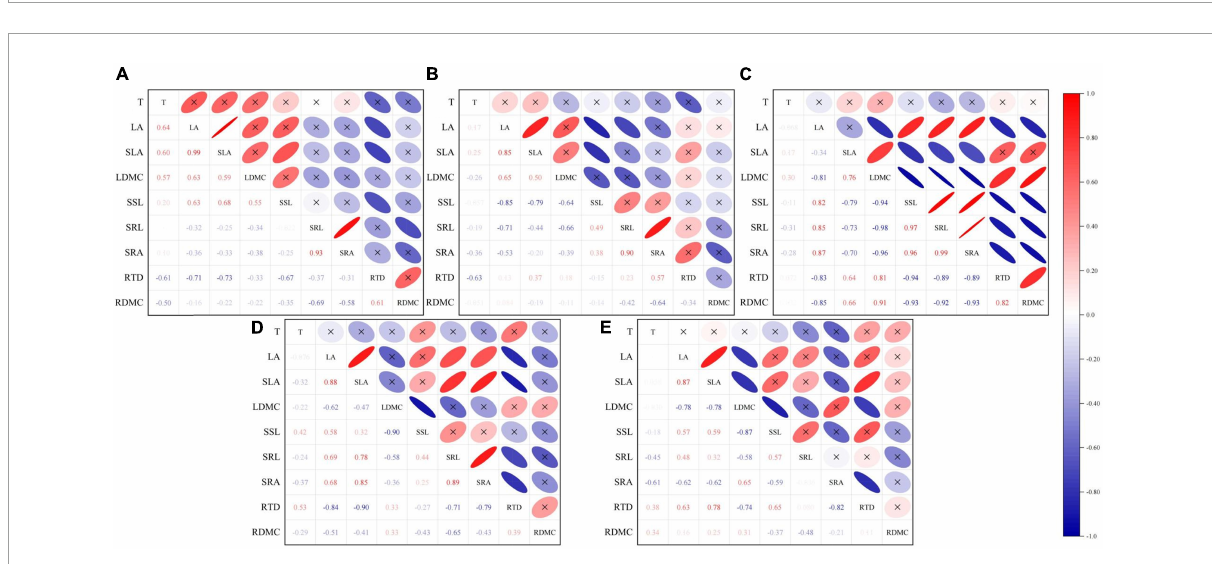
FIGURE4 Correlation analysis between functional traits of Abies georgei var. smithii seedlings in different age classes (Pearson). (A) 1–2 years old, (B) 3–4 years old, (C) 5–6 years old, (D) 7–8 years old, (E) 9–10 years old. Red represents positive correlation and blue represents negative correlation. The darker the color, the higher the